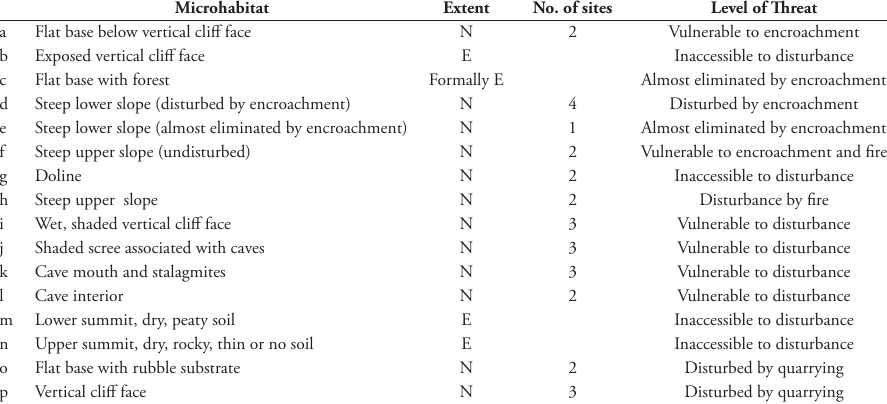
Table 2. Types of microhabitats on Batu Caves, their extent and level of threat.